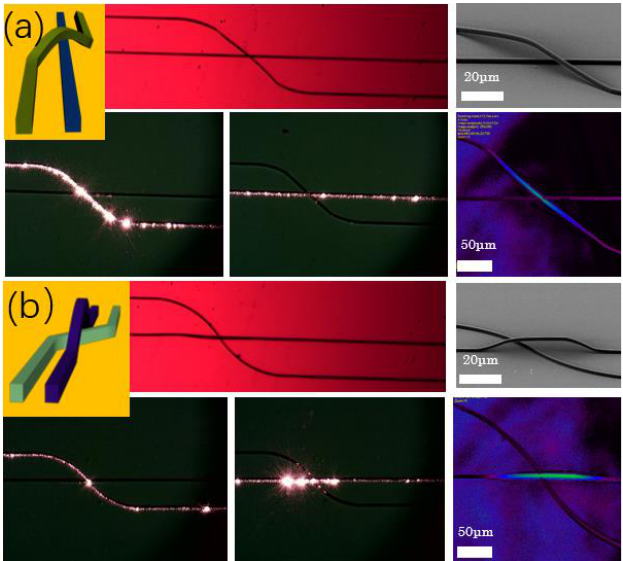
Figure 3. Schematic diagrams and characterization images of ( a ) jumper wire across the straight-line waveguide and ( b ) jumper wire across the curved waveguide.